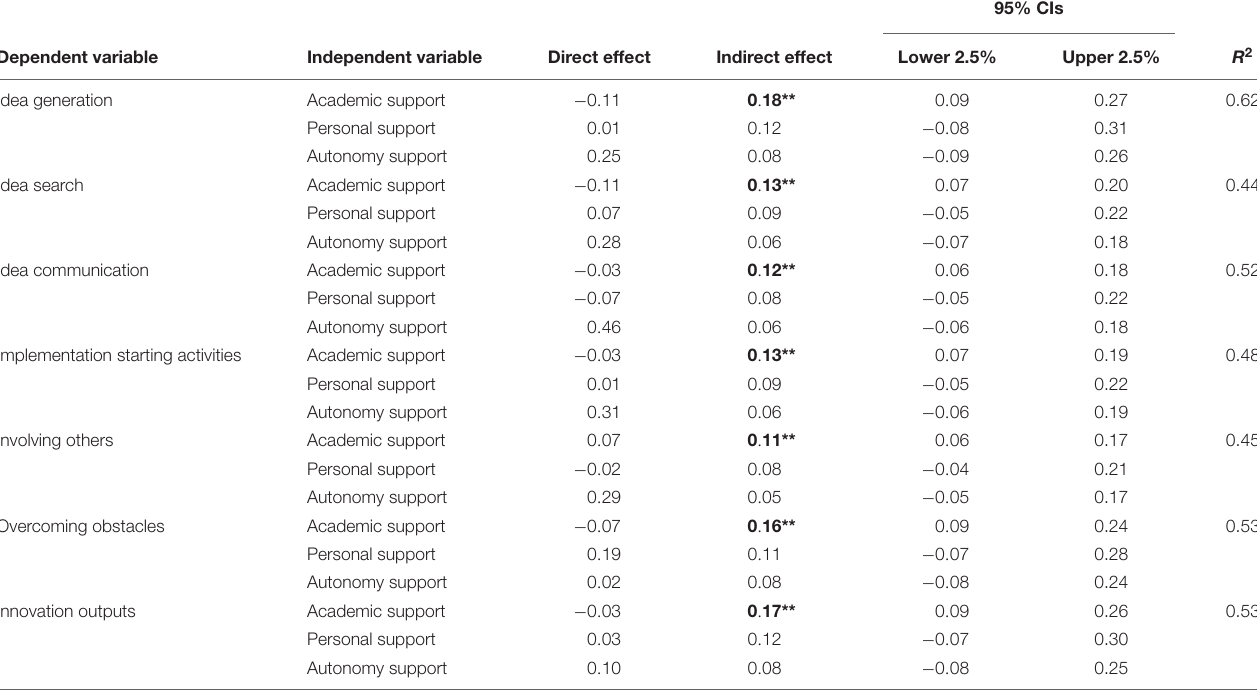
TABLE 4 | The estimates of direct effects and indirect effects of the 95% confidence